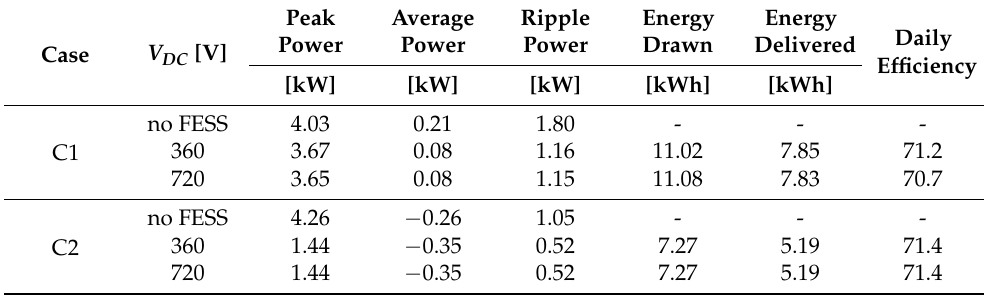
Table 6. FESS power and energy performance achieved in cases C1 and